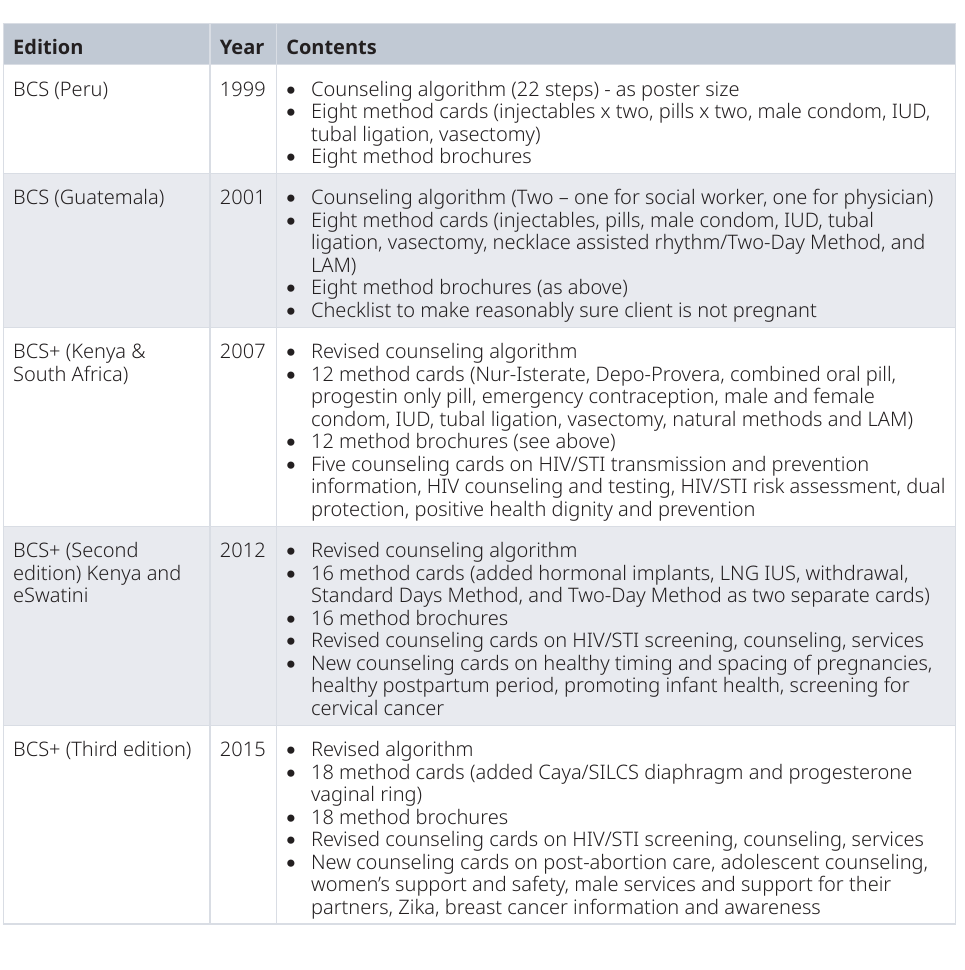
Table 1. Content of Balanced Counseling Strategy (BCS) and Balanced Counseling Strategy Plus (BCS+) editions.